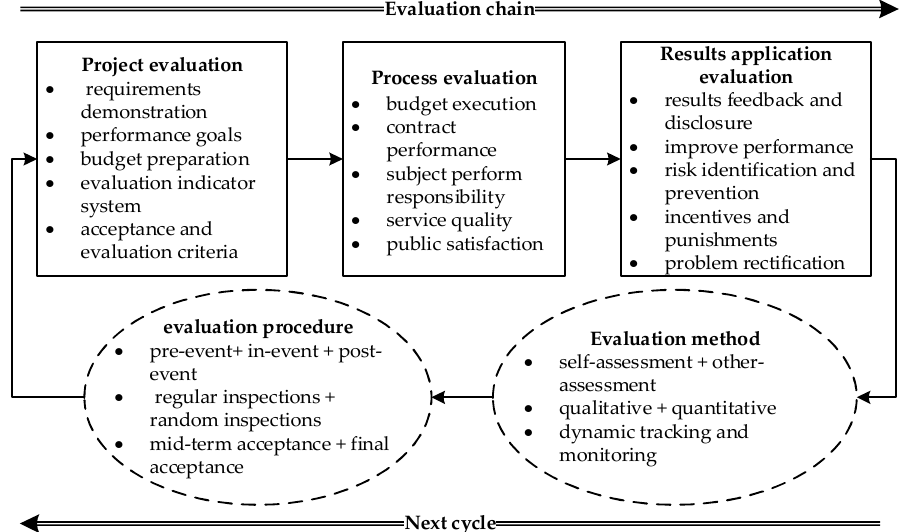
Figure 6. The whole process evaluation chain of government purchasing of ecological services.